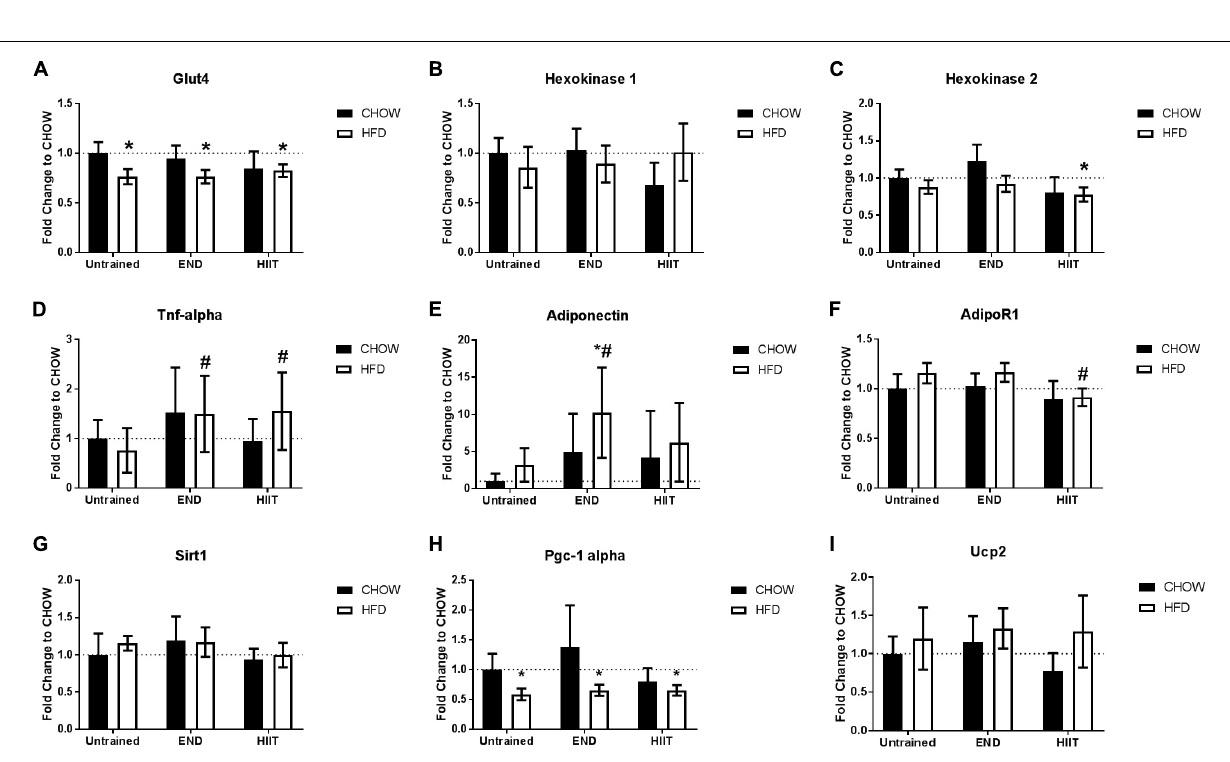
Frontiers in Physiology |